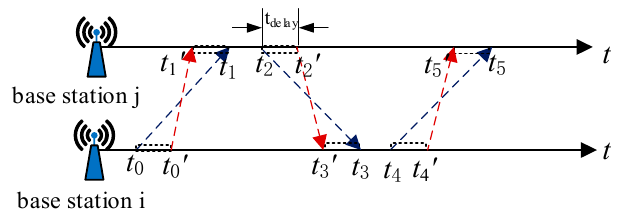
Figure 1. Principle diagram of SDS-TWR.